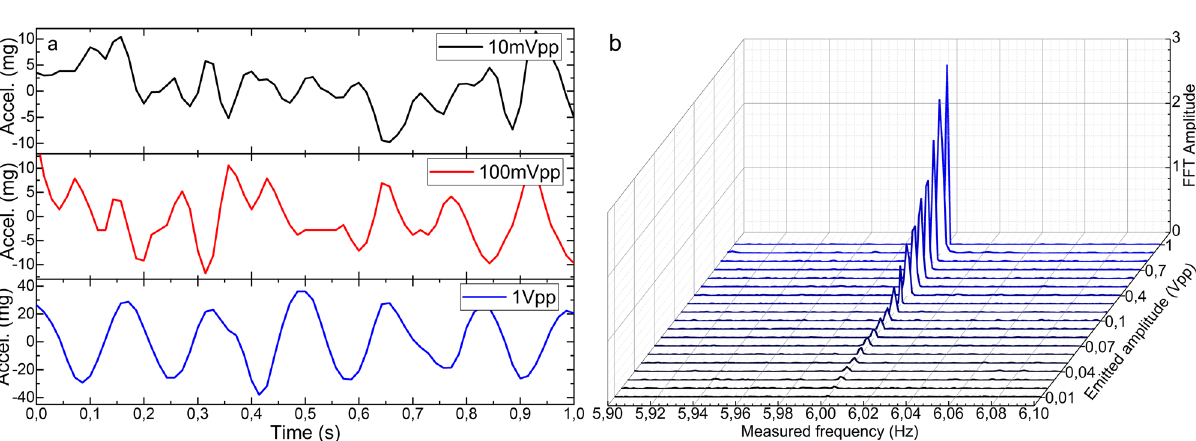
Figure 11. Results of the acceleration measurements in the electronic accelerometer. ( a ) Time response of three representative cases, and ( b ) FFT amplitudes for sinusoidal signals of 6 Hz and amplitudes from 1 Vpp down to 10